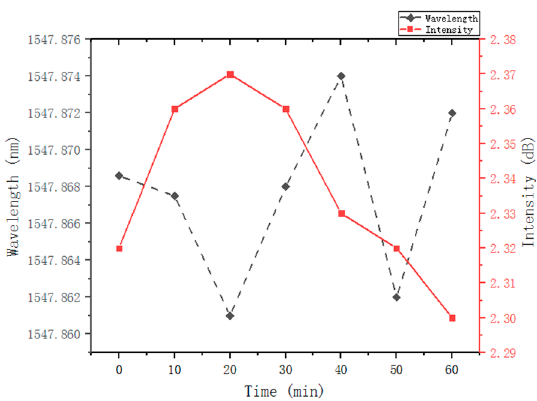
Figure 8. The shift of the center wavelength (dash line) and the fluctuation of laser powers (solid line) within 1 h.